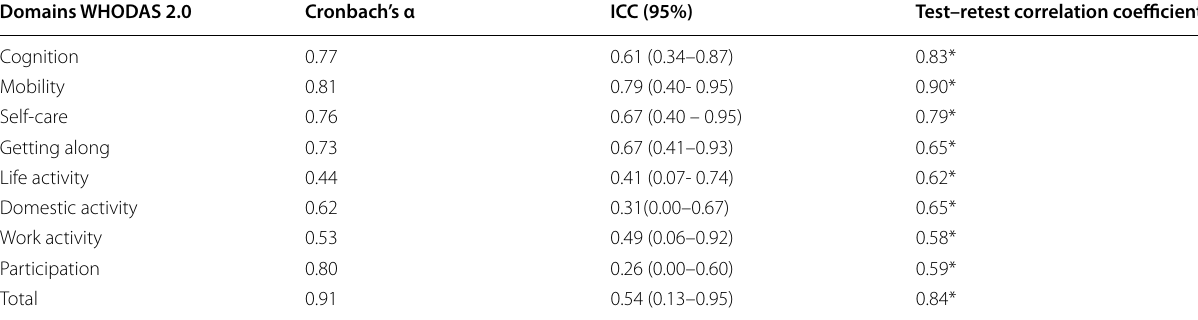
Table 3 Reliability (Cronbach’s α and ICC) of the WHODAS 2.0 domains